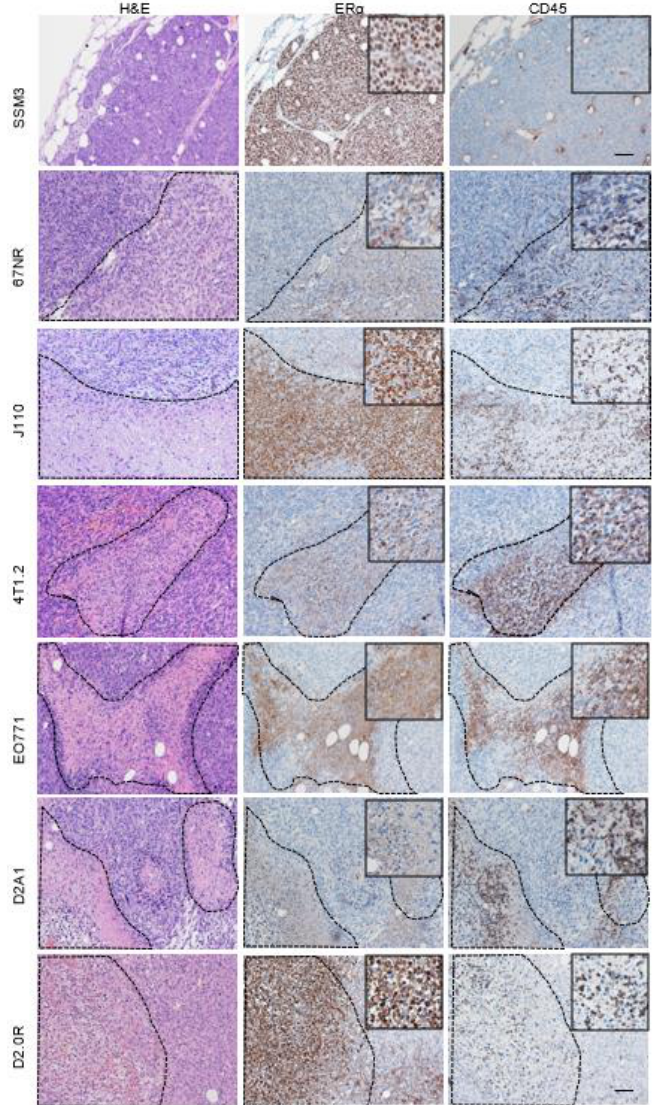
Figure 2. Distribution of Er α positive and CD45-positive cells in syngeneic tumours. Immunohisto- chemical staining of Er α and CD45 in tumours derived from different syngeneic mouse mammary tumours. ER α staining in the cytoplasm or, in the case of the J110 cell line, in the nucleus, shows concurrent staining with CD45, thus representing immune cell infiltrates. Dotted lines delineate areas of immune infiltration separate from epithelial cell counterparts. Scale bar SSM3 = 100 µm. Scale bar for all other tumours = 50 µm.